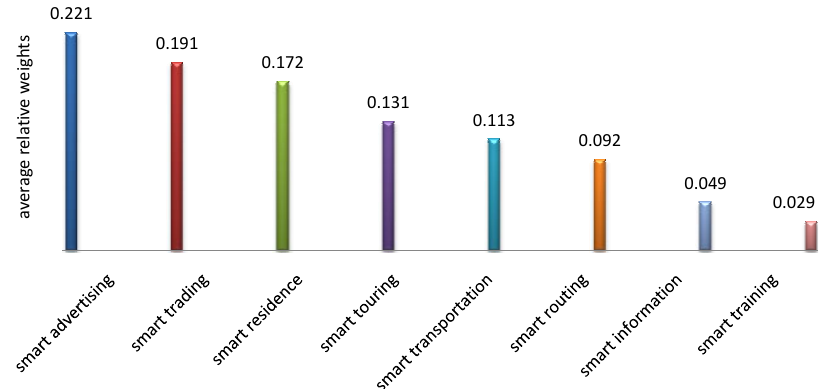
Fig. 7. Prioritization order of new business opportunities in the electronic tourism industry of Chabahar